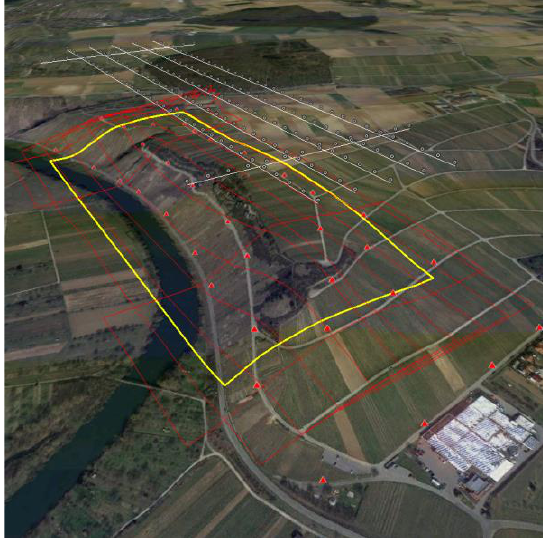
Figure 3: Test-site with planned flight lines, image footprints and signalized points. Figure 3 visualizes the flight planning for the test site. In addition to flight lines and image footprints, the 33 signalized control points are overlaid to the terrain surface. These points were available at an accuracy of 1cm from terrestrial GPS measurement.